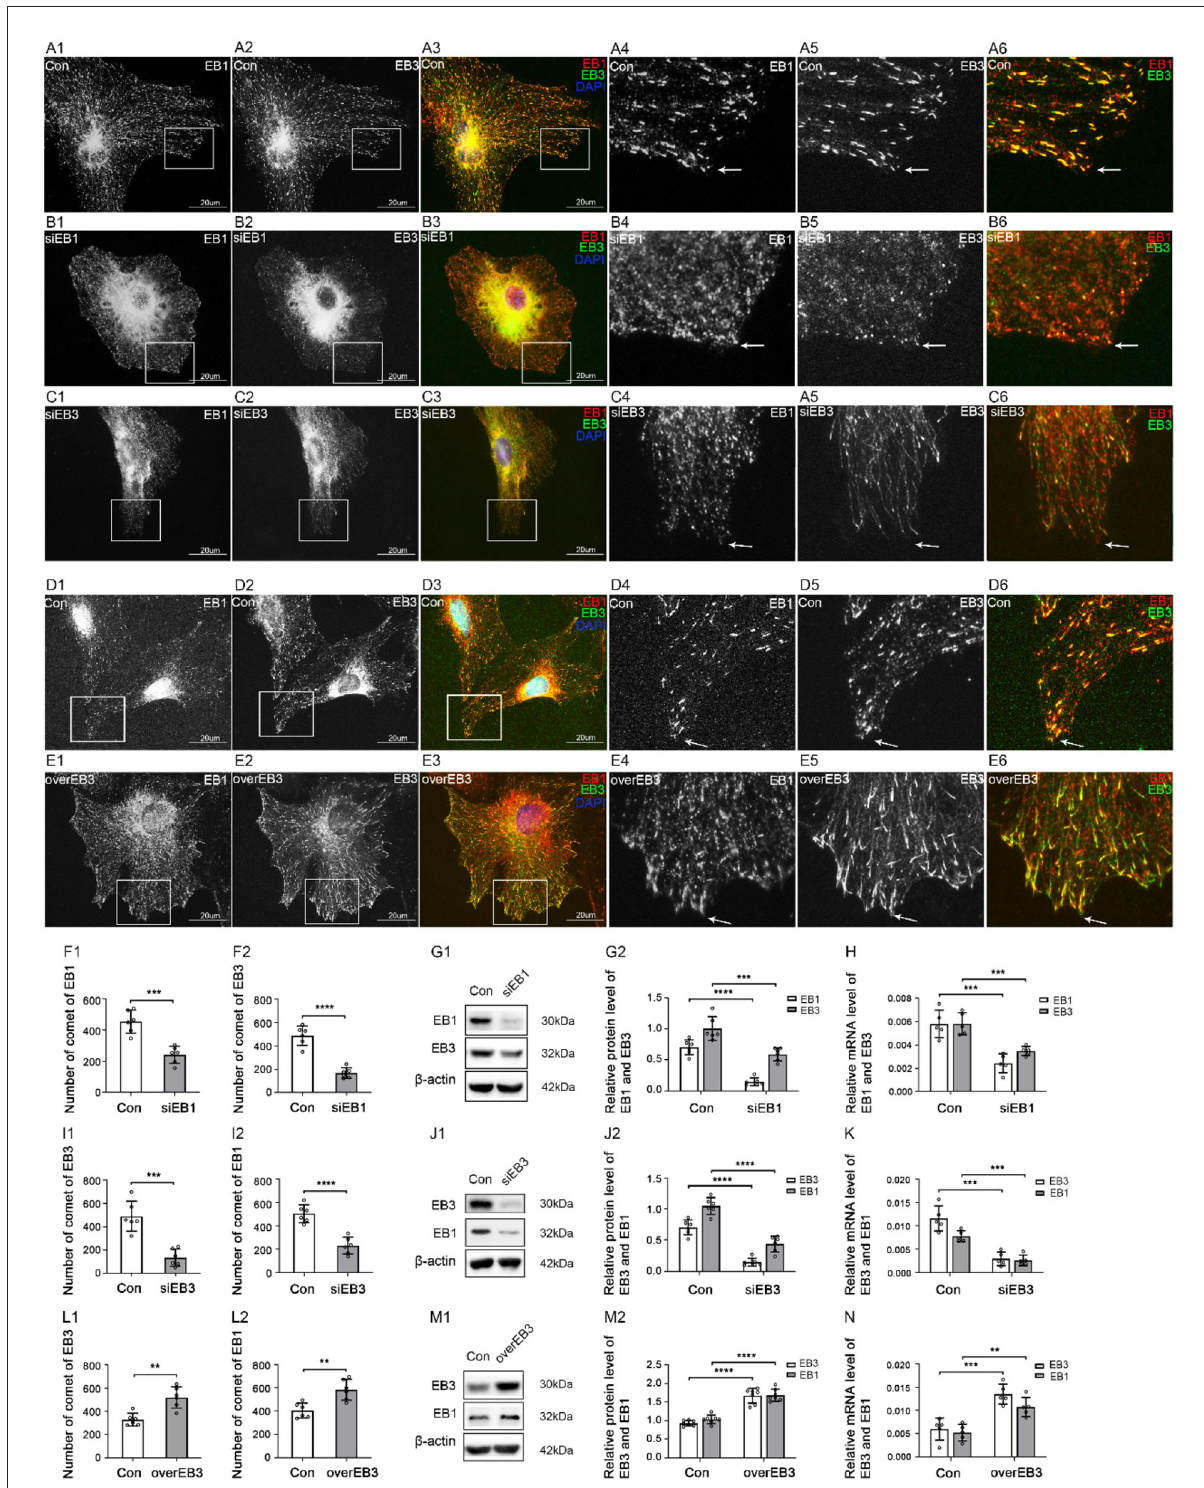
FIGURE6 The expression of EB1 and EB3 after EB1/3 was silenced or EB3 was overexpressed in astrocytes. (A–E) Immunofluorescence showed that EB1 [ (A–E) red signal] was co-expressed with EB3 [ (A–E) green signal] in astrocytes in the control group [Con (A,D) ], EB1 silence group (B) , and EB3 silence group (C) or overexpression group (E) . (F,I,L) The number of comets of EB1 and EB3 in astrocytes after EB1/EB3 was silenced or EB3 was overexpressed. (G,J,M) Western blot and (H,K,N) RT-PCR analysis of protein and mRNA levels of EB3 and EB1 after EB1/EB3 was silenced or EB3 was overexpressed compared with the control group ( n = 6, p < 0.05). (A–N) Number of panels. * p < 0.05, ** p < 0.01, *** p < 0.001, **** p <